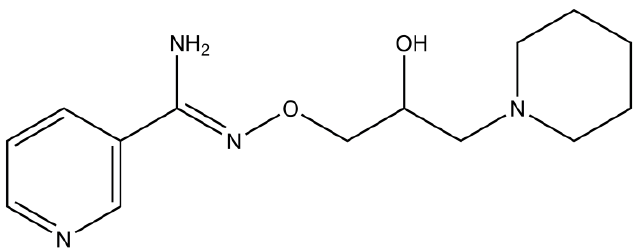
Figure 1. Chemical structure of O -(3-piperidino-2-hydroxy-1-propyl)-nicotinic amidoxime, also